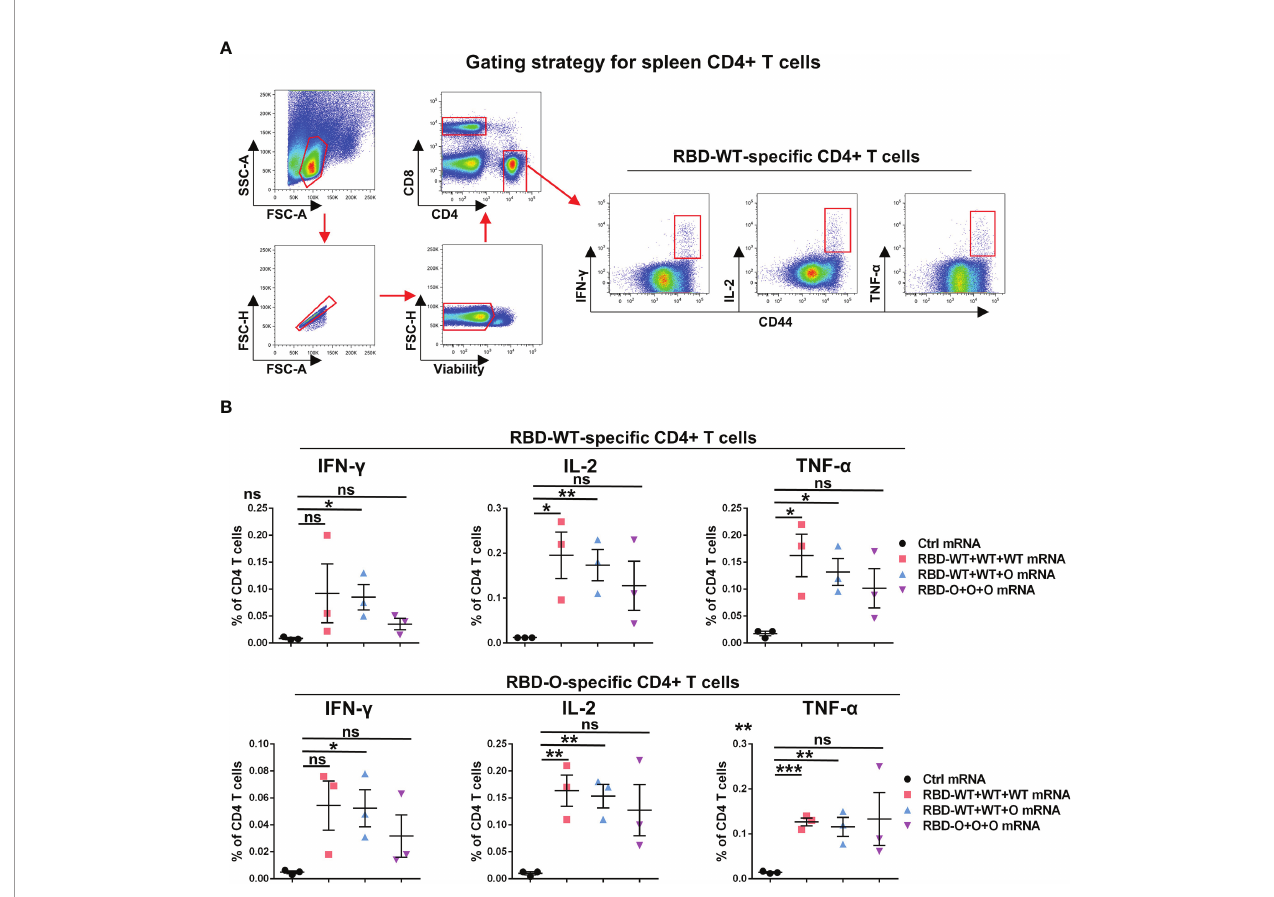
FIGURE 4 | RBD-WT- and RBD-O-speci fi c CD4 T-cell intracellular cytokine staining (ICS) assays. The splenocytes isolated from control or vaccinated individual mice were stimulated with Omicron-RBD or WT-RBD proteins overnight, and the expression of the intracellular cytokines IFN- g , IL-2, and TNF- a in CD4 T cells was analyzed by fl ow cytometry. (A) Representative gating strategy for the identi fi cation of antigen-speci fi c CD4 T cells within the mouse spleen. (B) Frequencies of RBD- WT- and RBD-O-speci fi c CD4 T cells in spleen were measured by intracellular cytokine staining. Each symbol represents one mouse. Data are presented as mean ± SEM. p values were analyzed with unpaired t-test and indicated as follows: ns, not signi fi cant; * p < 0.05; ** p < 0.01; *** p <